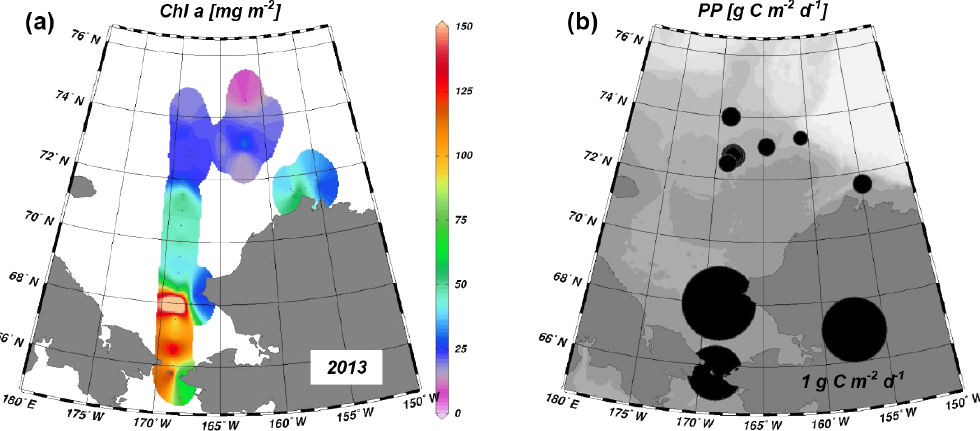
Figure 4. (a) Chlorophyll a integrated over the water column (mg m − 2 ) and (b) daily primary productivity in the water column (gC m − 2 d − 1 ) obtained from the 2013 R/V Mirai